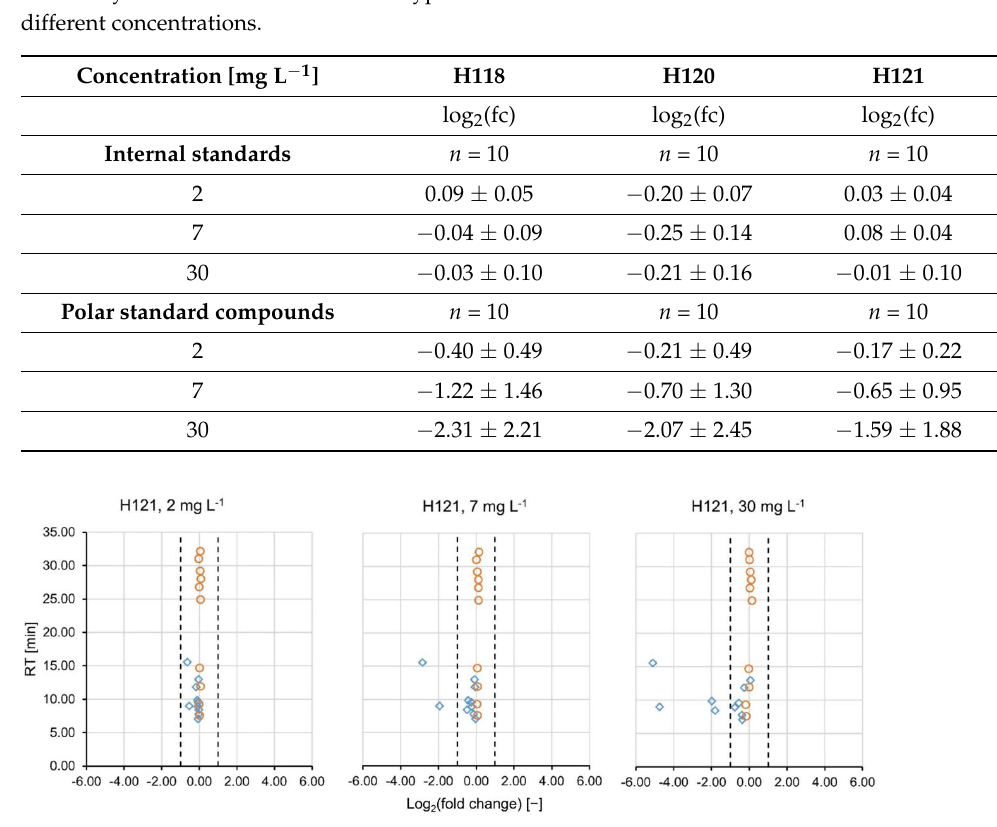
Figure 1. The base-2 logarithm of the fold changes of the HILIC standards (added prior to PAC treatment, blue diamonds) and the internal standards (added prior to analysis, orange circles) are plotted versus their RTs. The dashed lines mark the consistency interval where no compound re- moval is